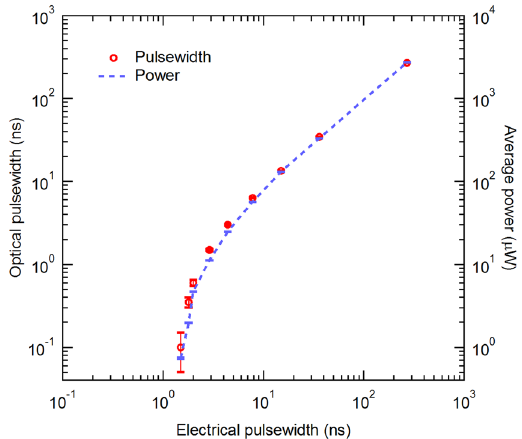
Figure 7. Optical pulse widths and the average optical powers plotted against the electrical pulse width of the whole laser